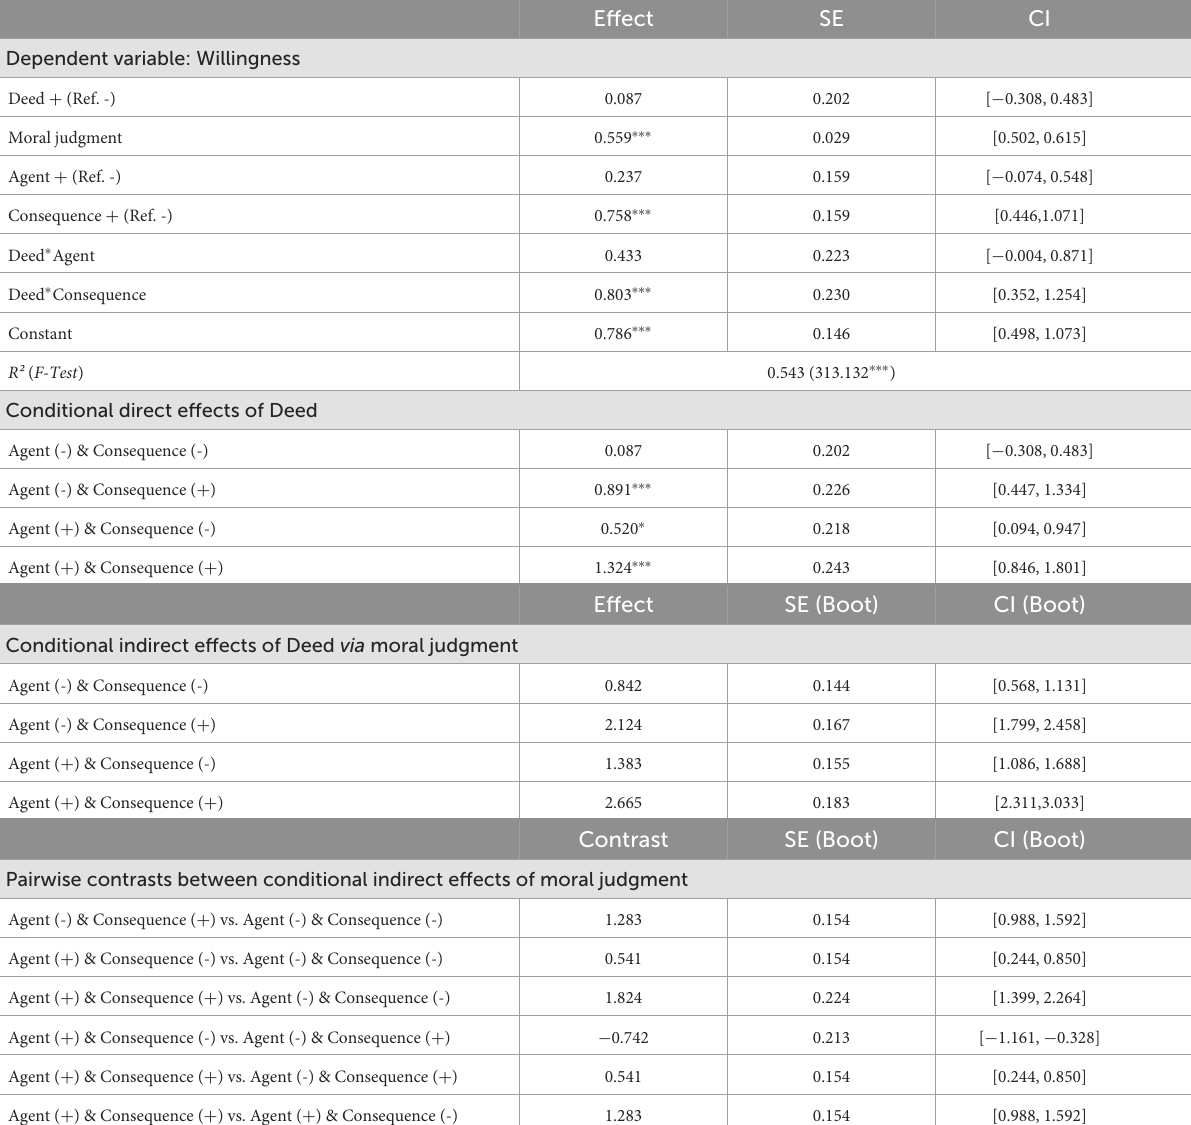
TABLE 4 Dependent variable models of the conditional mediation models ( N = 1,349).